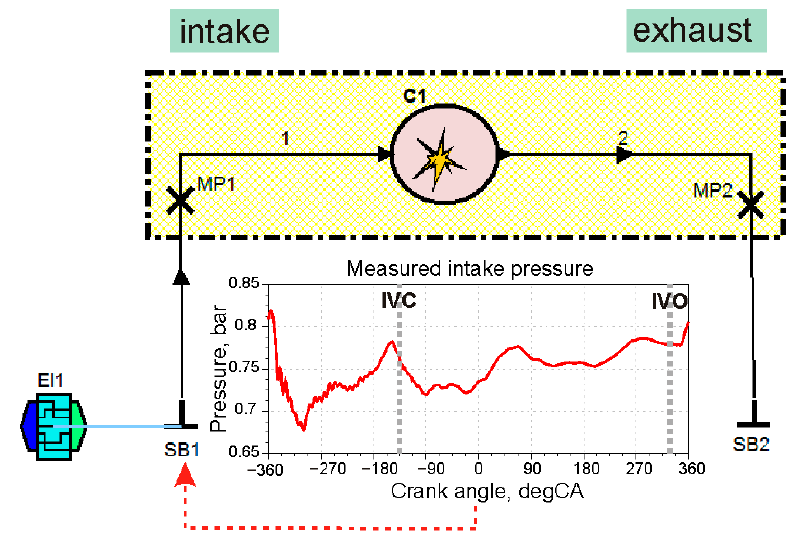
Figure 5. Reduced 0D/1D simulation model defined in AVL Boost v2013.2.